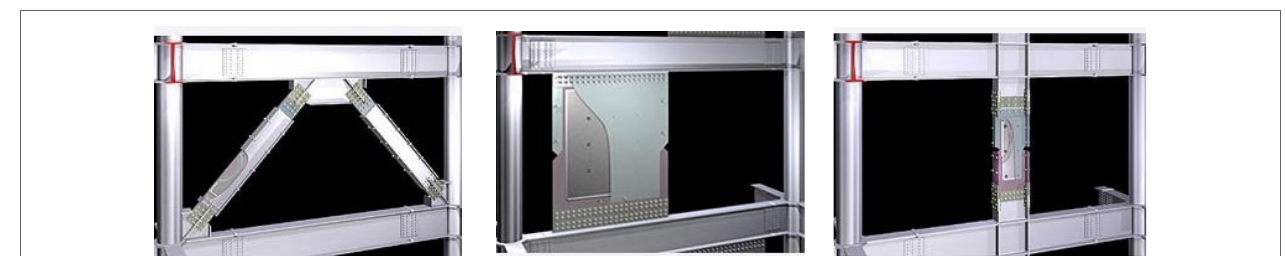
FIGURE 2 | Configurations of story-installation-type VEDs